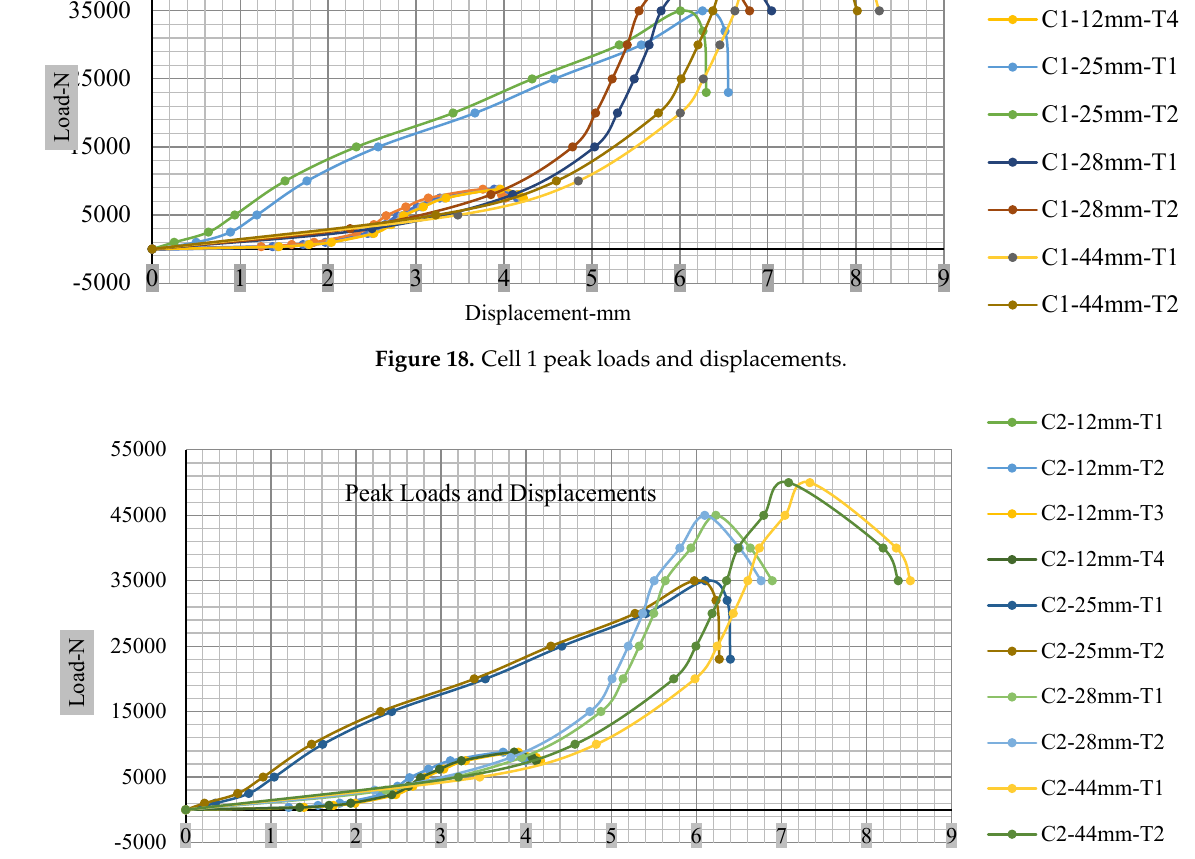
Figure 20. Cell 3 peak loads and displacements. Figure 21. Cell 4 peak loads and displacements.